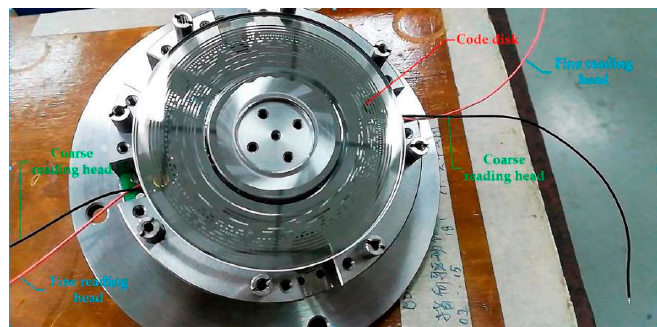
Figure 7. Internal structure of the photoelectric angle encoder.